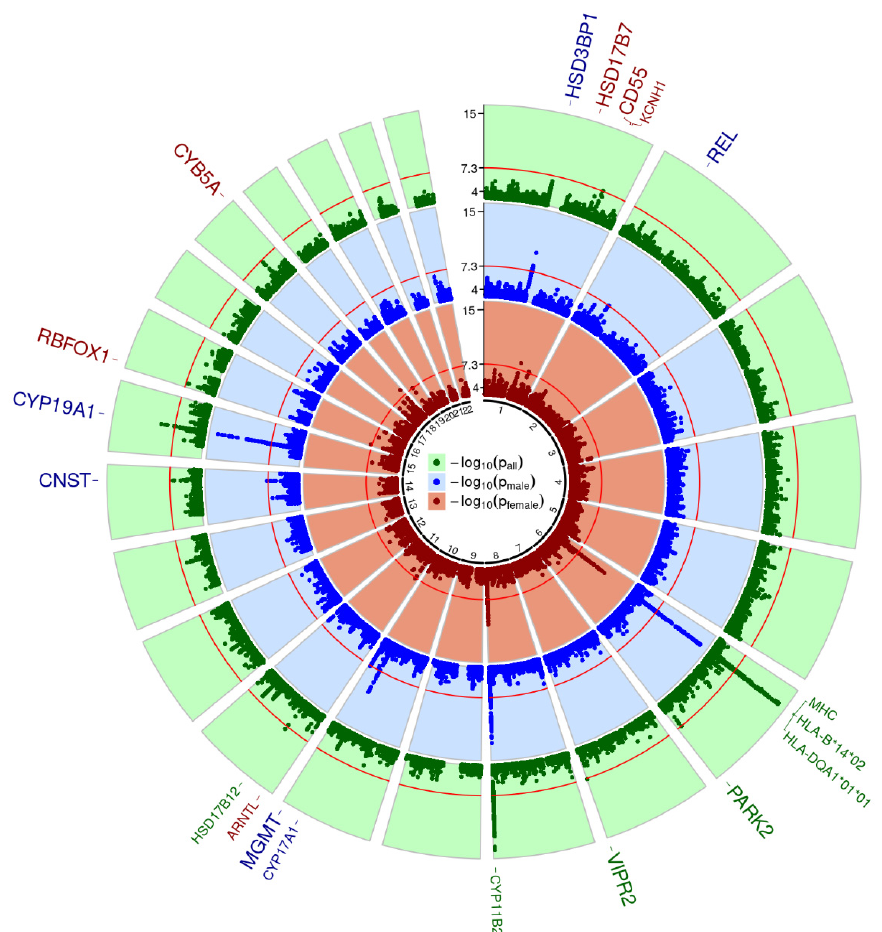
Figure 2. Circular Manhattan plot of GWAMA results. Minimal p -values across analyzed traits are presented for each analysis group (green—all samples; blue—male only; red—female only). In each Manhattan circle, the genome-wide significance threshold of 5 × 10 − 8 is given a red circle ( − log 10 transformed). Loci with genome-wide significant SNPs are named outside the circles. They are colored according to the analysis setting showing the highest significance for that locus. Increased font size indicates novelty, while replicated loci are displayed in smaller font size. Table 1. Study characteristics of LIFE-Adult and LIFE-Heart. Binary variables other than sex are given in absolute counts and percentage. Continuous variables are reported by mean (SD) or median [range]. Abbreviations: CAD, coronary artery disease; BMI, body mass index; WHR, waist-hip-ratio; P4, progesterone; 17-OHP, hydroxyprogesterone; A4, androstenedione; Aldo, aldosterone; T/E2, ratio of testosterone and